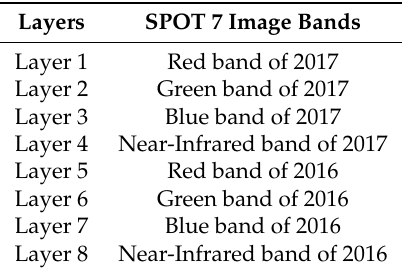
Table 1. Layer combinations of stacked